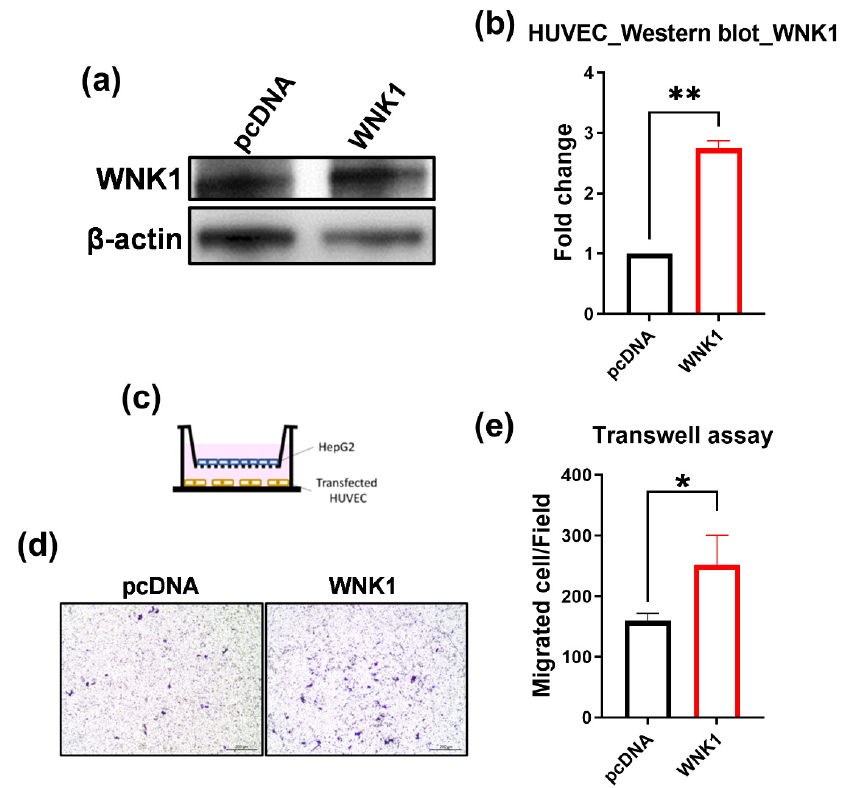
Figure 9. Overexpression of WNK1 in HUVEC cells significantly increases the migration of HepG2 cells. ( a ) The protein levels of WNK1 were examined by Western blot. ( b ) Quantification of Western blot indicates that overexpression of WNK1 in HUVEC cells significantly increases the WNK1 protein levels. ( c ) HUVEC cells with WNK1 overexpression were seeded in the lower chamber while HepG2 hepatoma cells were loaded in the upper chamber of the transwell plate. ( d ) Representative images of hepatoma cell migration. The scale bar is 200 µ m in length. ( e ) Quantified data of the transwell migration assay shows that WNK1 overexpression in HUVEC cells significantly increases the migrated HepG2 cells, indicating that WNK1 plays an important role in endothelial cells for stimulating hepatoma cell migration. We performed three replicates for each Western blot and transwell analysis. Unpaired Student’s t -test (two tailed test) was used for statistical analysis. *: p ≦ 0.05; **: p ≦ 0.01.